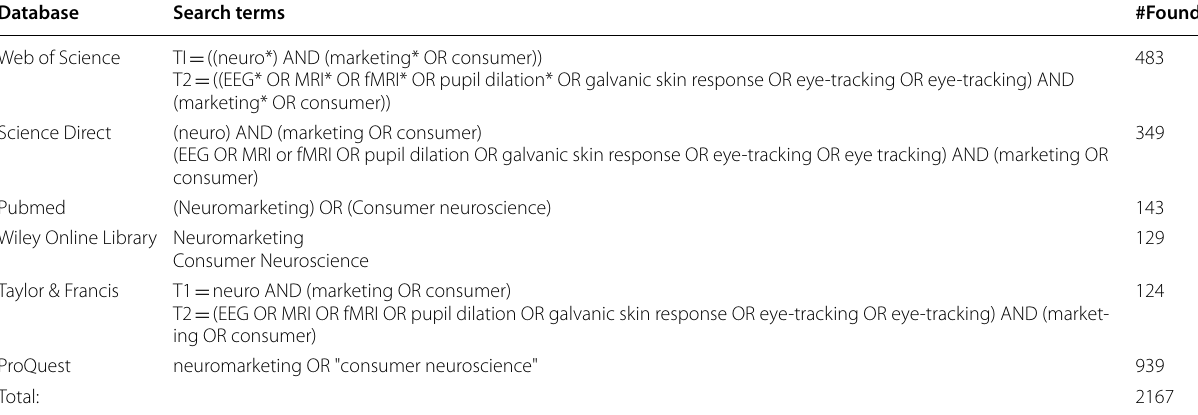
Table 1 A summary of the journal databases searched, the search terms used for each database, and the number of journals produced from each search